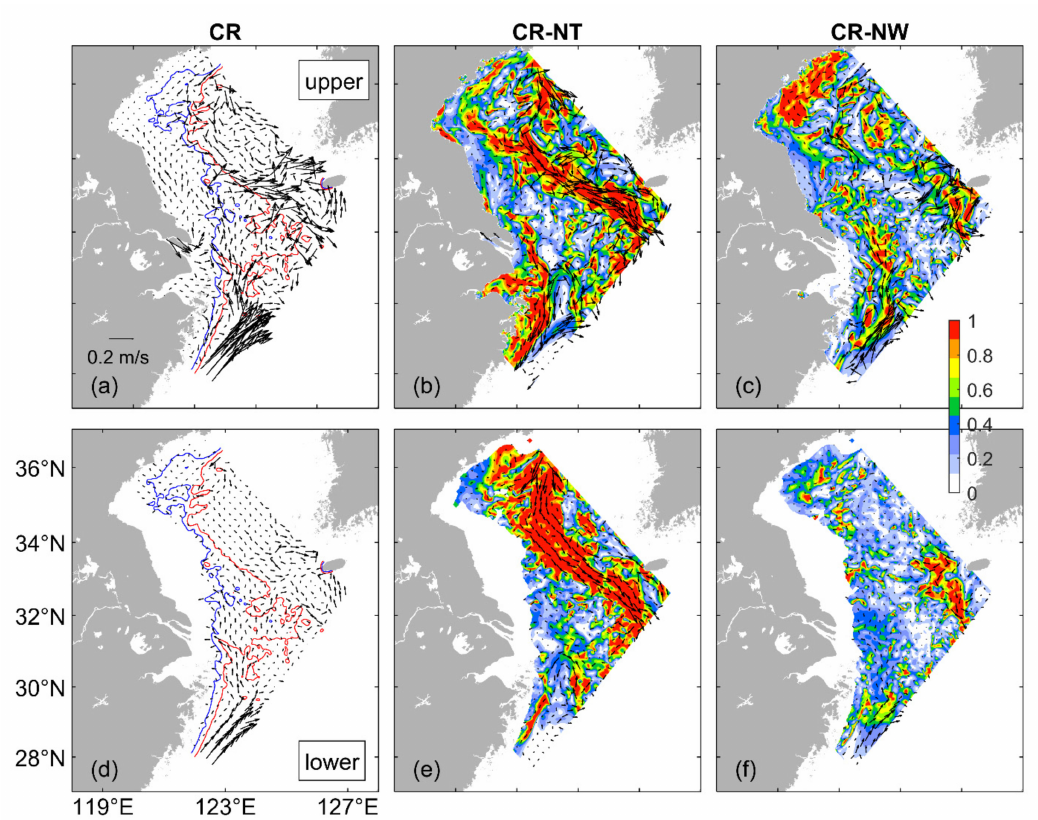
Figure 11. Same as Figure 10 except for in August 2015. Distribution of monthly mean currents averaged in ( a ) the upper layer from the sea surface to 25 m and ( d ) the lower layer from 25 m to sea bottom in August 2015 calculated from the inner model results in the case of CR. The blue and red contours in ( a , d ) are isobaths of 30 m and 50 m, respectively. Distribution of impact index ( P i , color image) and current differences (arrows) in ( b , c ) the upper layer and ( e , f ) the lower layer ( b , e ) between cases CR and NT and ( c , f ) between cases CR and NW. Vectors are plotted at every 9th grid